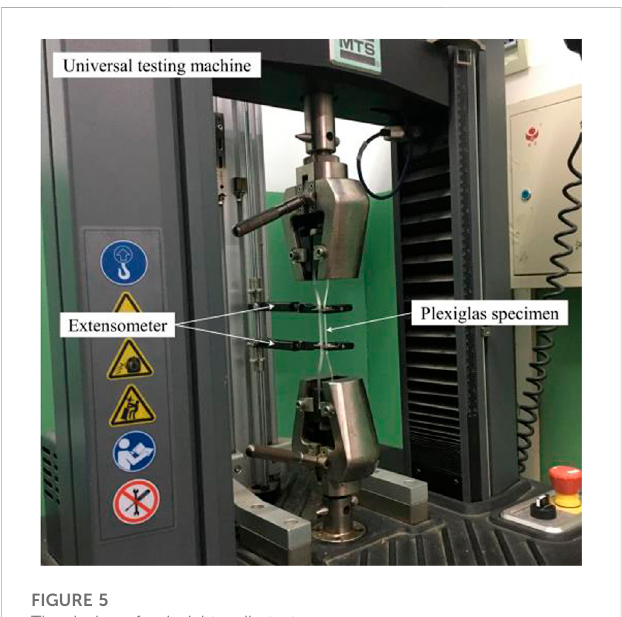
FIGURE 5 The device of uniaxial tensile test.